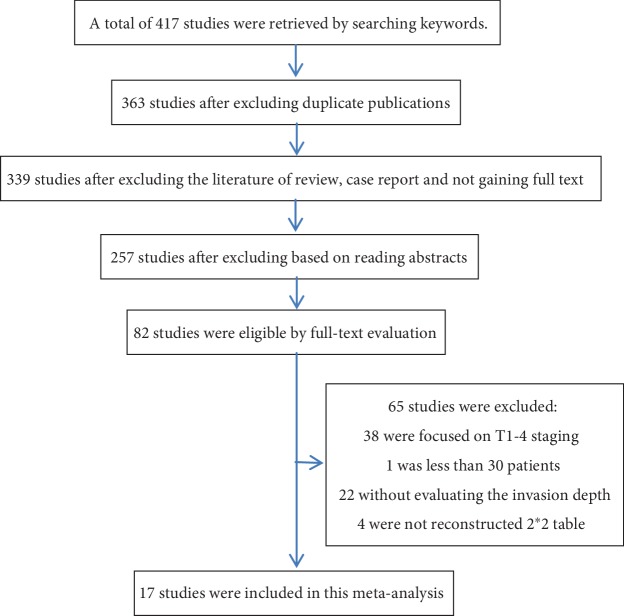
Flow diagram of the studies identified in the meta-analysis.